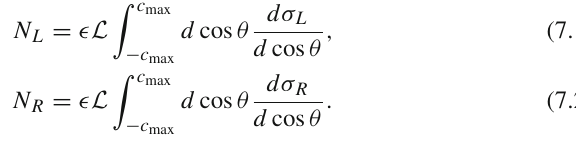
Fig. 14 The strength of FB asymmetry (cid:8) A FB as a function of VEV v χ ( = M / 3 g ) forbothleftandright-handedpolarizedcross-sections R Z (cid:2) of the e + e − → μ + μ − process at the ILC. Red dashed (solid) line rep- resents (cid:8) A FB for U ( 1 ) R case for left (right) handed polarized cross- sections of the e + e − → μ + μ − process, whereas blue dotted (dashed) line indicates (cid:8) A FB for U ( 1 ) B − L case for left (right) handed polarized